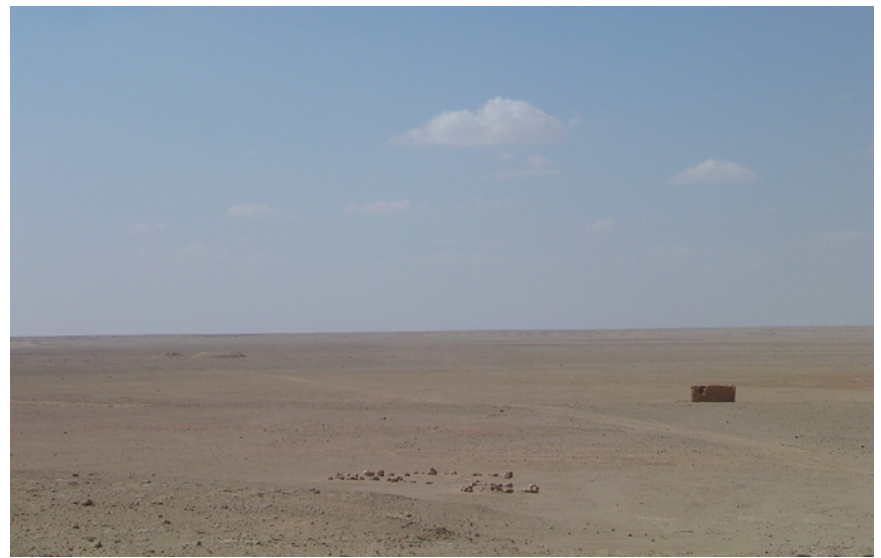
Fig. 12. Traces of tracks close to Bir Helua (cf. Fig. 4). The line of the track is slightly visible passing between the remains of a camp site (stones on the surface) and the small house. Close to the horizon in the left part of the photograph the spoil heaps of the Bir Helua. (Anna-Katharina